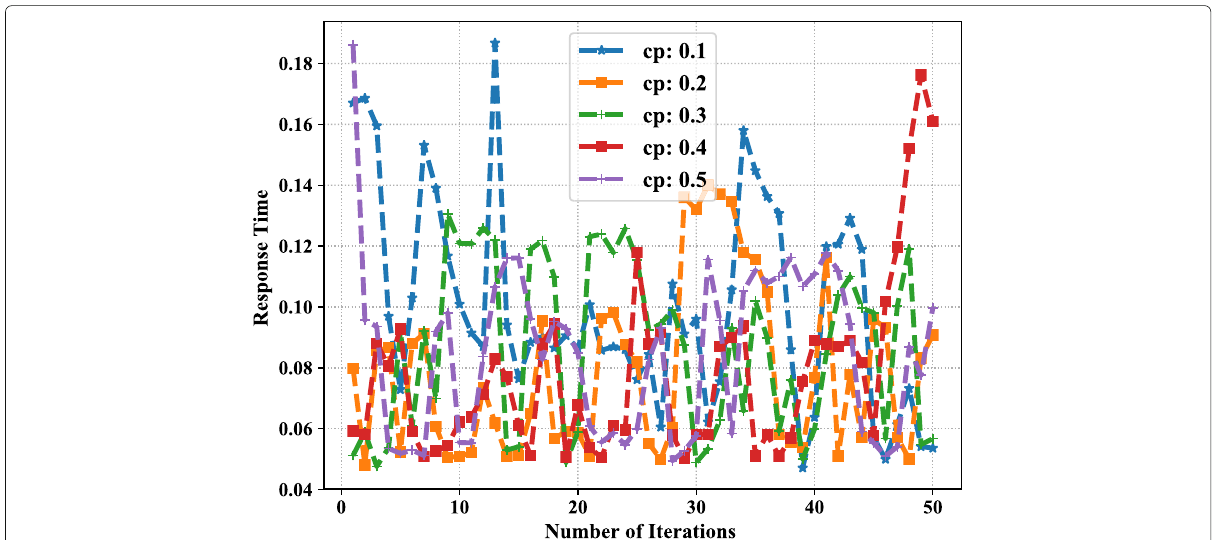
Fig. 5 Response times with different values of crossover